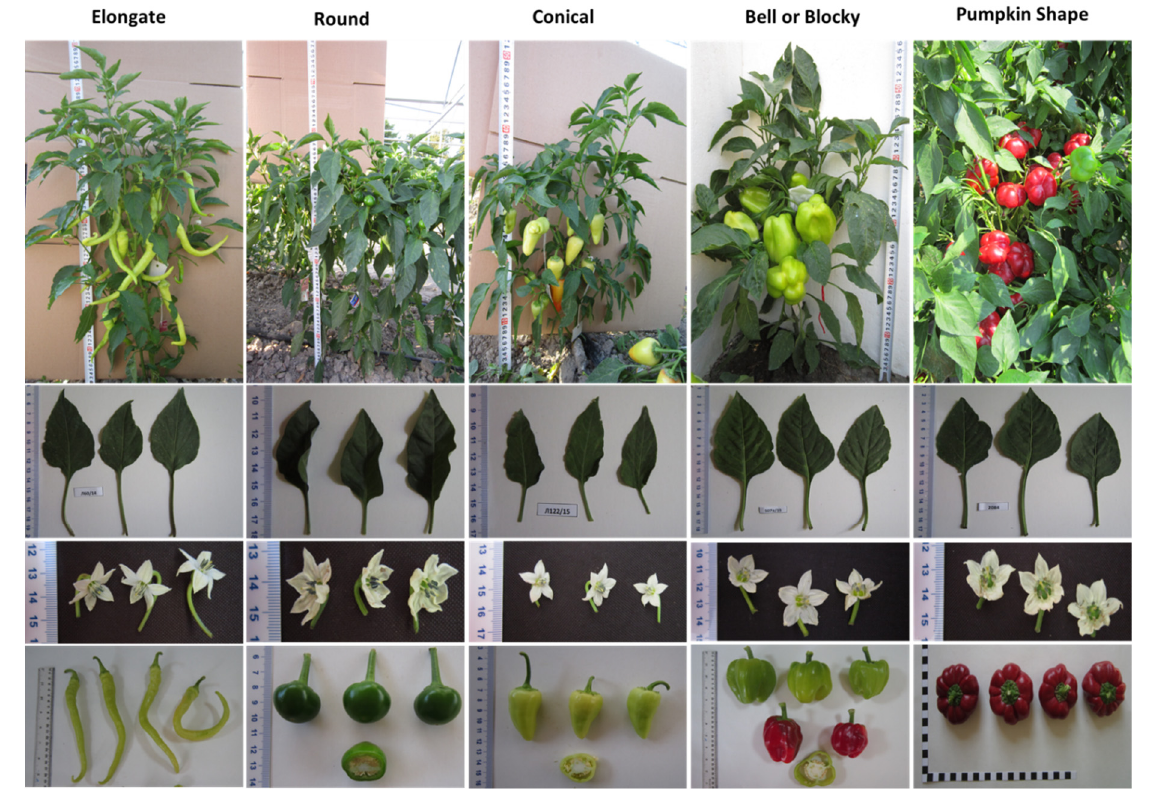
Figure 9. Varietal groups representing morphological variation of leaf, flower, fruit, and plant habitus. Accessions CAPS-10, CAPS-2, CAPS-7, CAPS-29, and CAPS-38 represent the Elongate, Round, Conical, Bell or Blocky, and Pumpkin-shaped varietal groups, respectively.